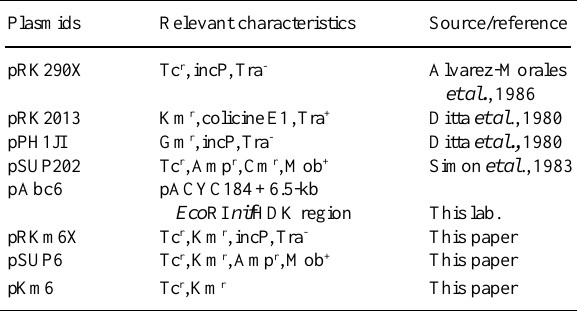
Table II - Plasmids used in the present study.